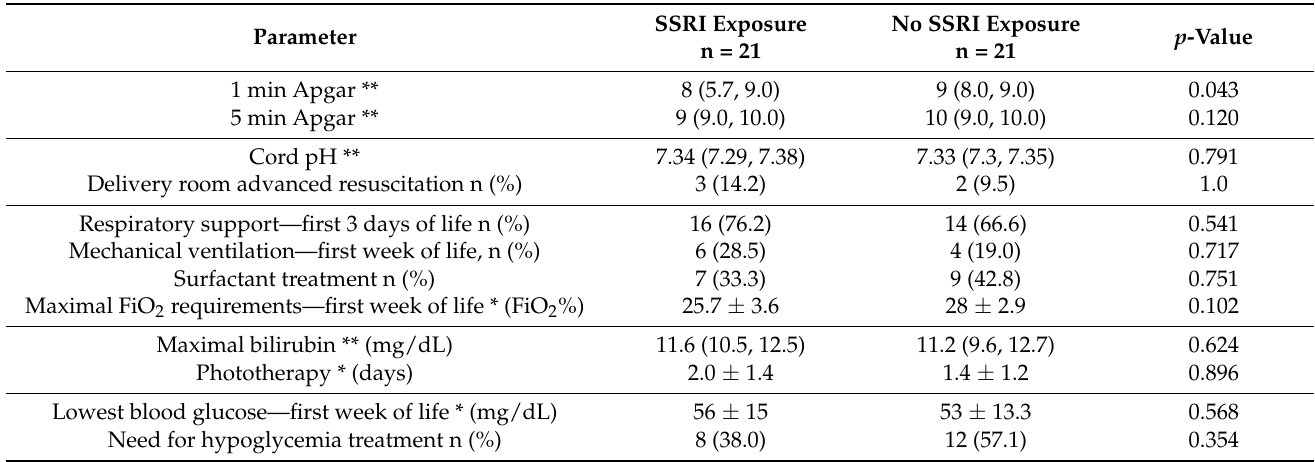
Table 2. Early respiratory and metabolic